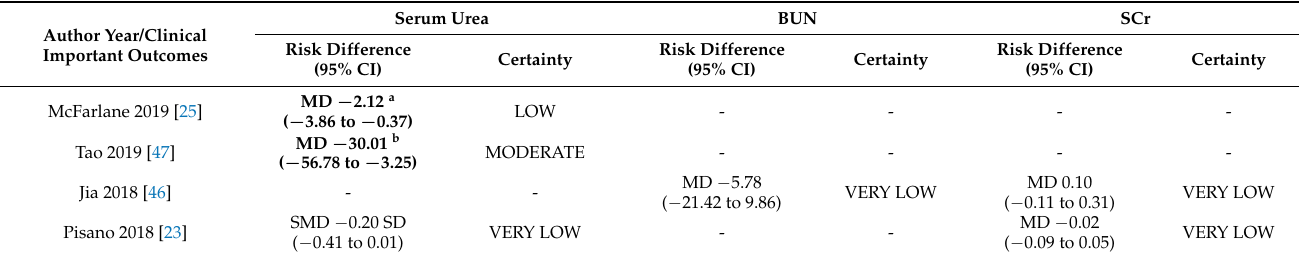
Table 6. Summary of clinical important outcomes and certainties on the renal protection effect of biotics compared to